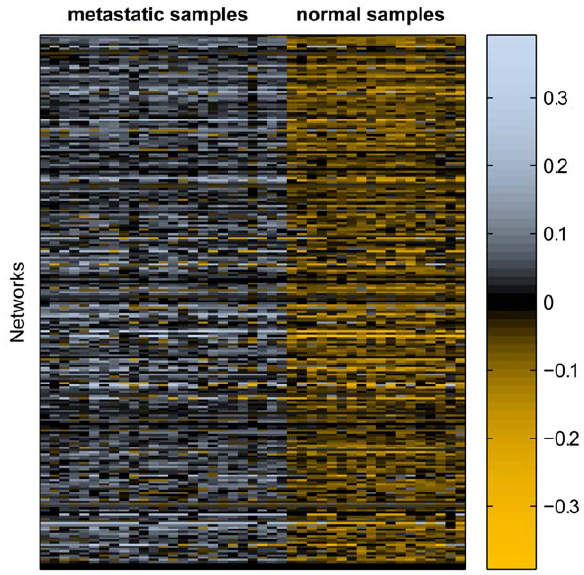
Figure 6. Differential rank conservation across all networks for a set of two prostate phenotypes. Positive rank difference scores predict a metastatic sample and negative difference scores predict a sample as